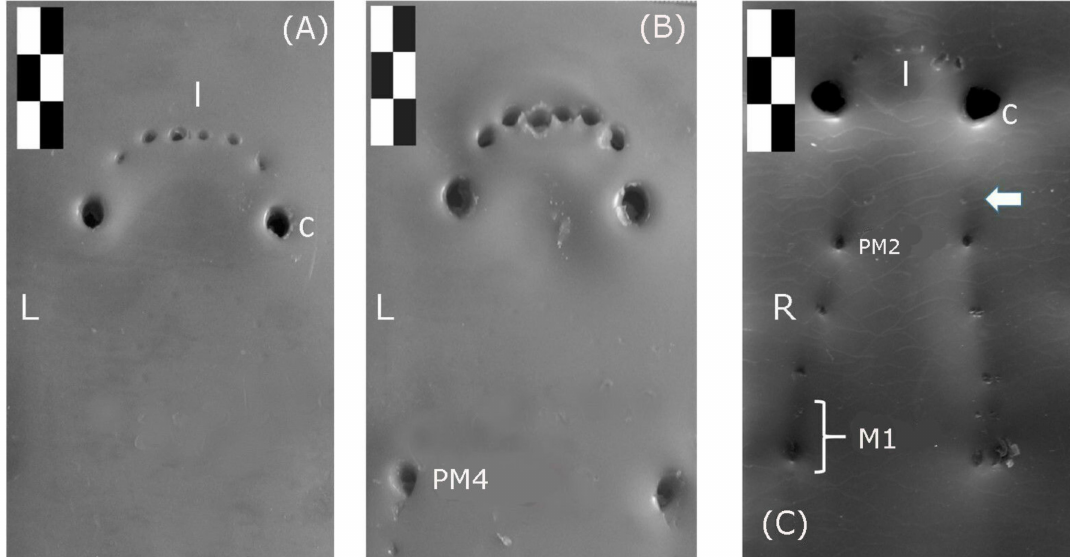
Figure 5. ( A ) Superficial bite mark caused by the maxillary dental arch of the Iberian wolf; ( B ) Deeper bite mark caused by the maxillary dental arch; ( C ) Deep bite mark caused by the mandibular dental arch (mandible). The length of each black / white rectangle at the top left corresponds to one